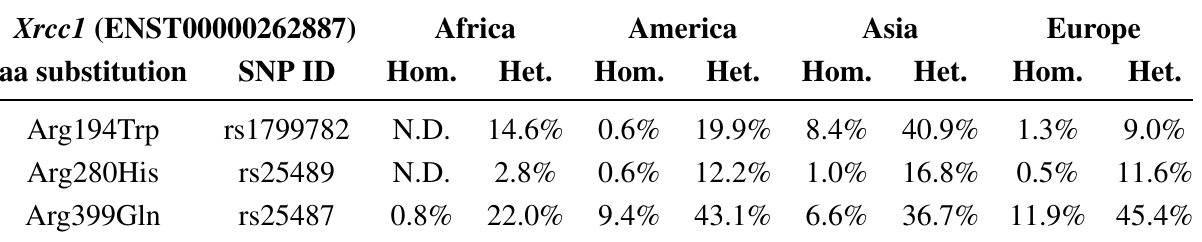
Table 1. Allele frequencies of the three most prevalent Xrcc1 SNPs known to date. Xrcc1